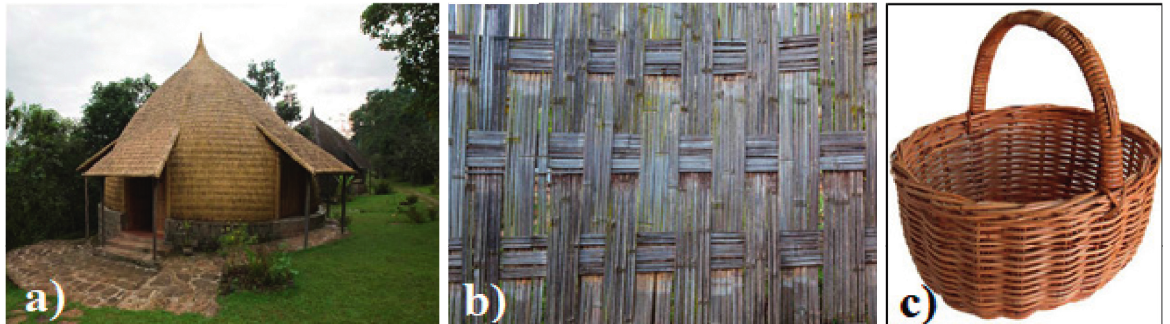
Figure 11: Traditional use of bamboo for (a) house construction, (b) fencing, and (c) household utensils (e.g.,